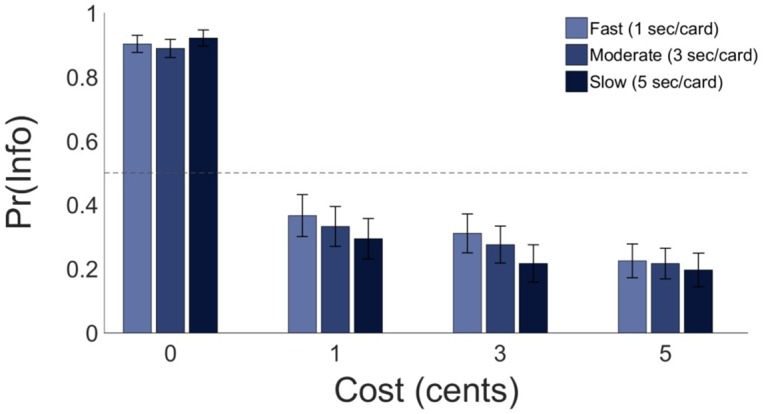
Behavioural results for Experiment 2.Mean proportion of informative stimulus choices (denoted Pr(Info)) as a function of information cost and information rate. Light blue bars represent the fast speed condition, medium blue bars the moderate speed condition, and dark blue bars the slow rate conditions. Error bars represent SEM. Proportions of information-seeking choices decreased as information rate slowed, particularly for positive information cost conditions (costs of 1, 3, and 5 cents). N = 40.